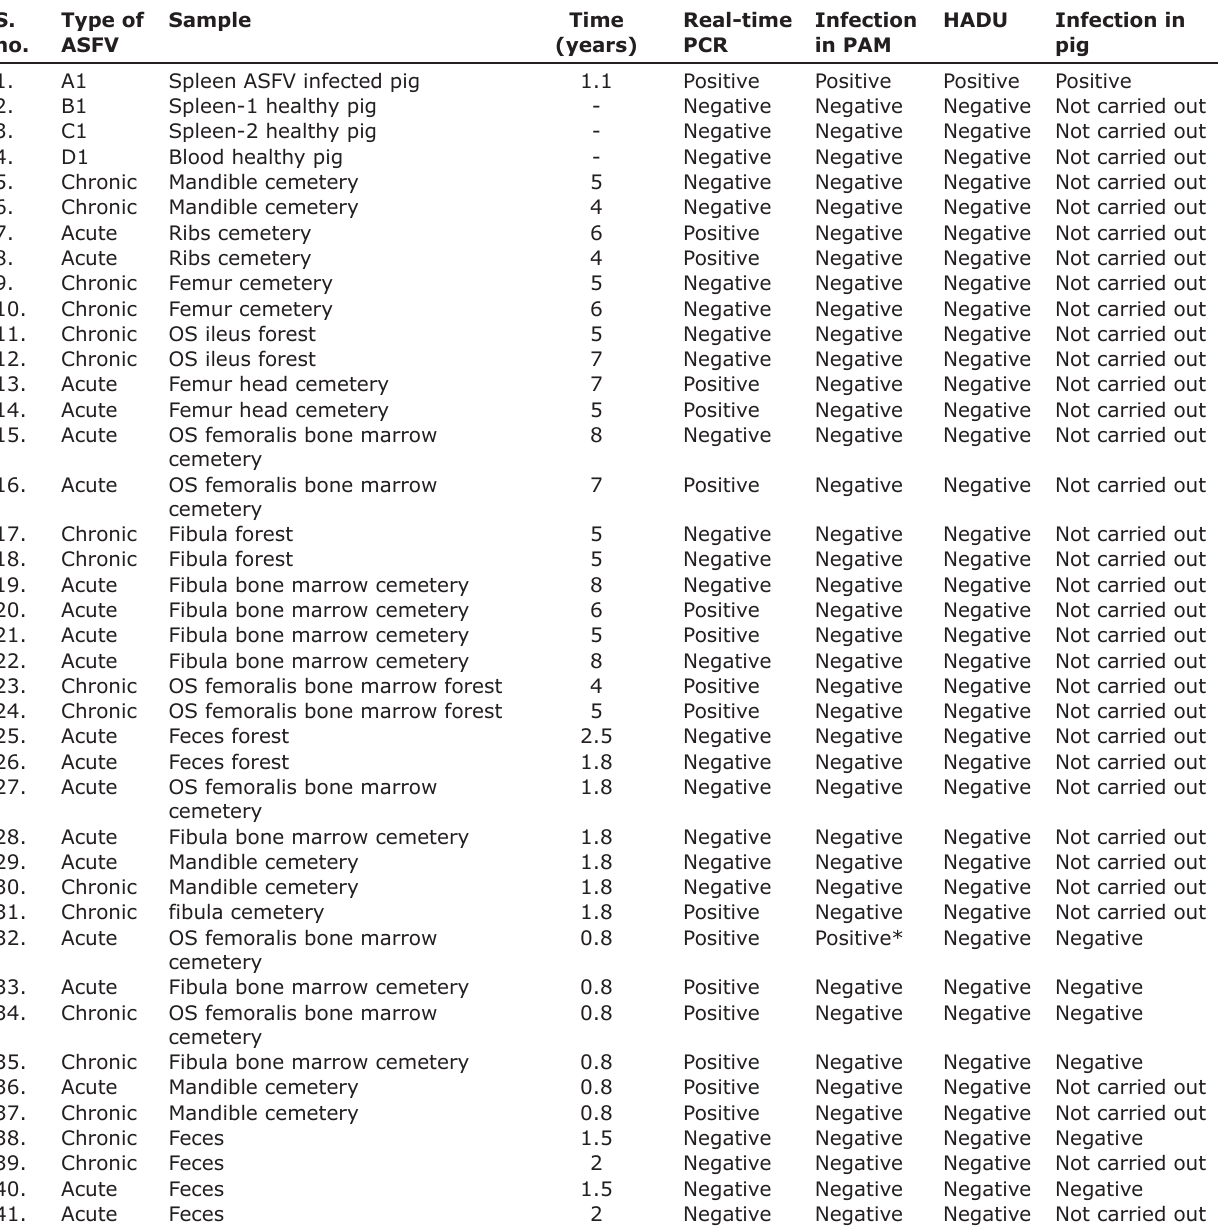
Table-1: Surviving of ASFV in bones, remnants of bone marrow, and feces of infected pigs. S.